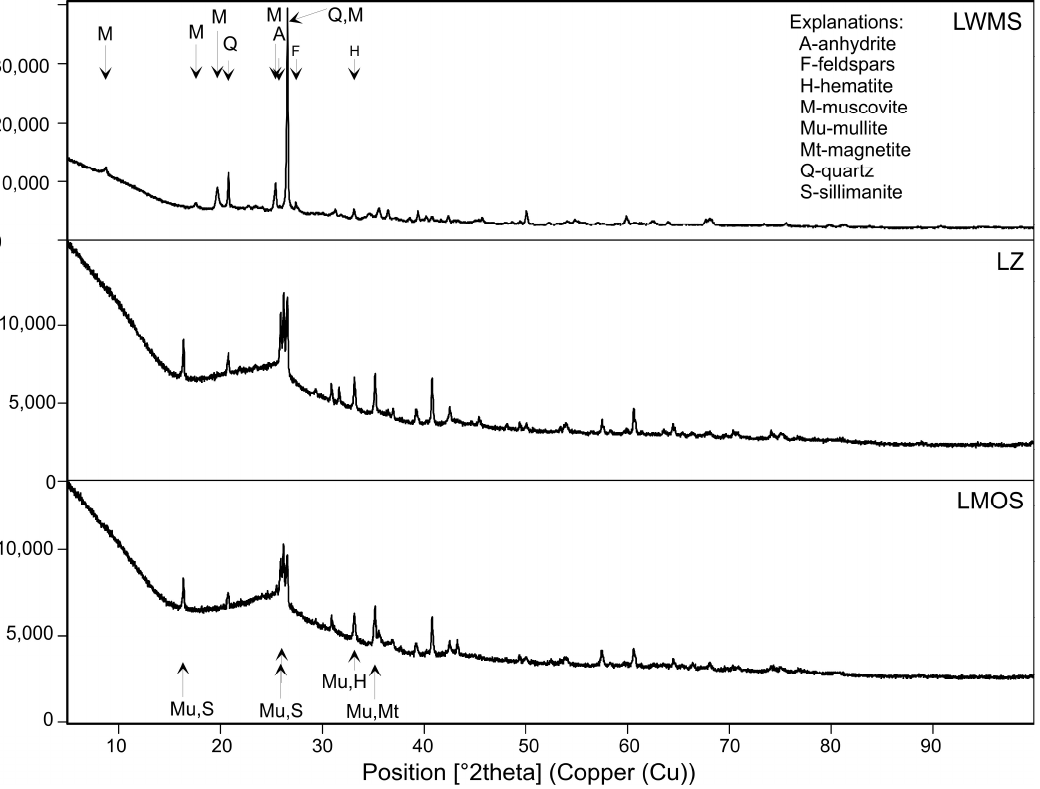
Figure 2. Microscope image inclusions of sillimanite rods in isotropic glass (transmitted light): ( a ) sample LZ—one nicol, magnification 200×; ( b ) sample LMOS—one nicol, magnification 400×.